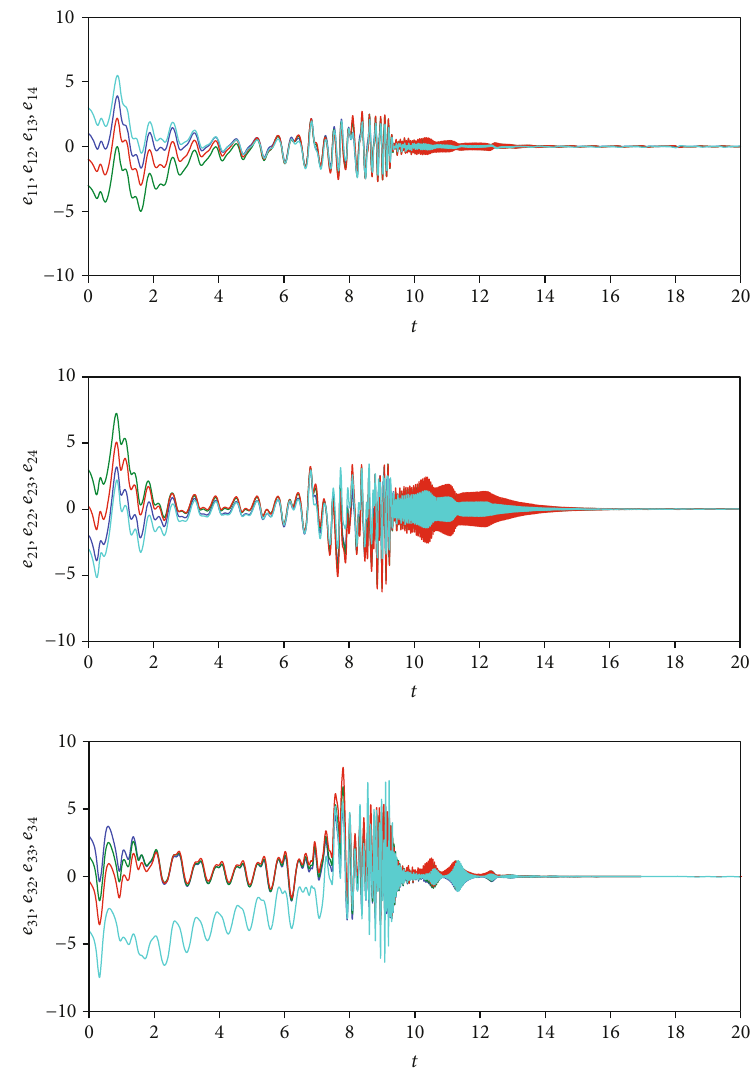
Figure 4: The synchronous errors of the triweight complex network with diverse